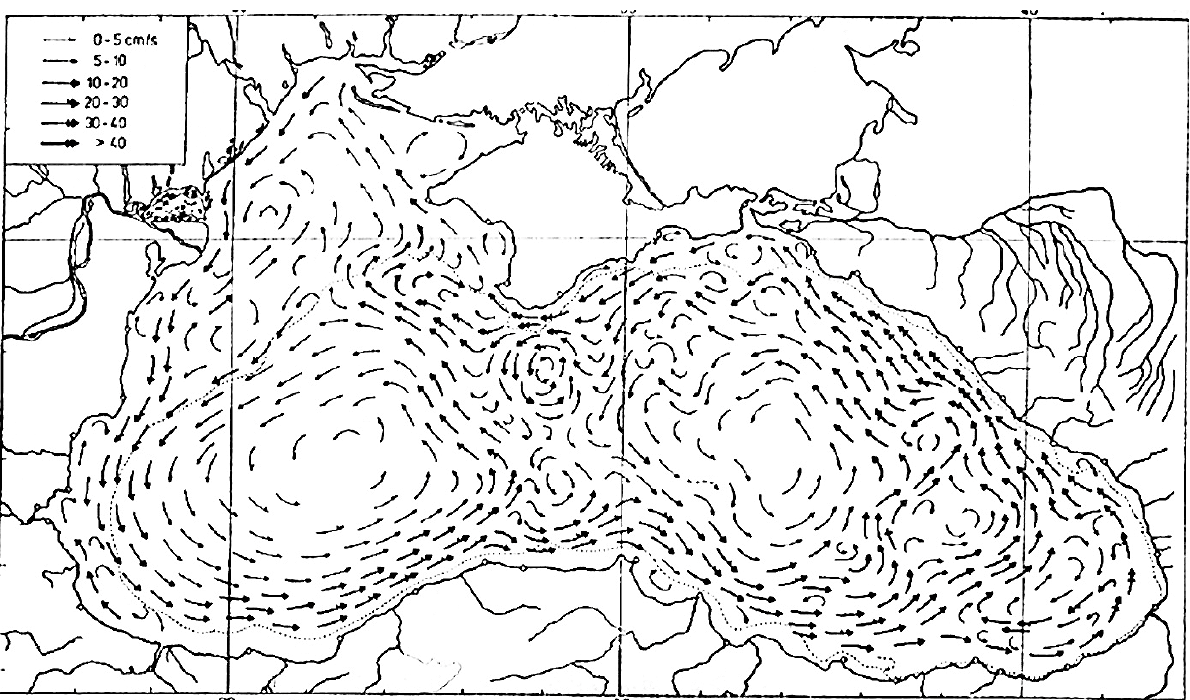
Figure 1. General scheme of circulation in the surface layer in the Black Sea. Neumann, 1942 [14].